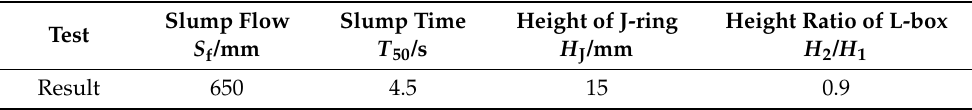
Table 1. Workability test results of